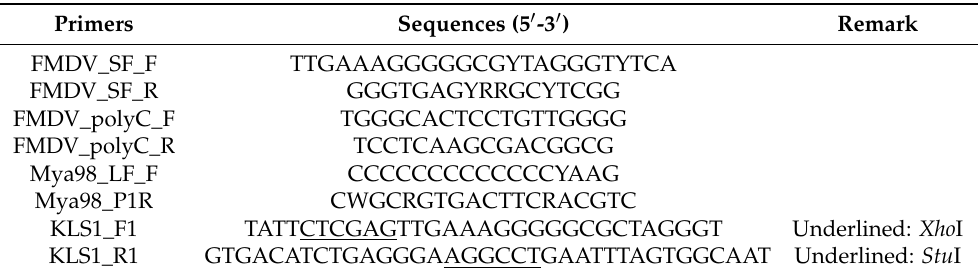
Table 1. Synthetic oligonucleotides used for amplification of FMDV 5 (cid:48) UTR.